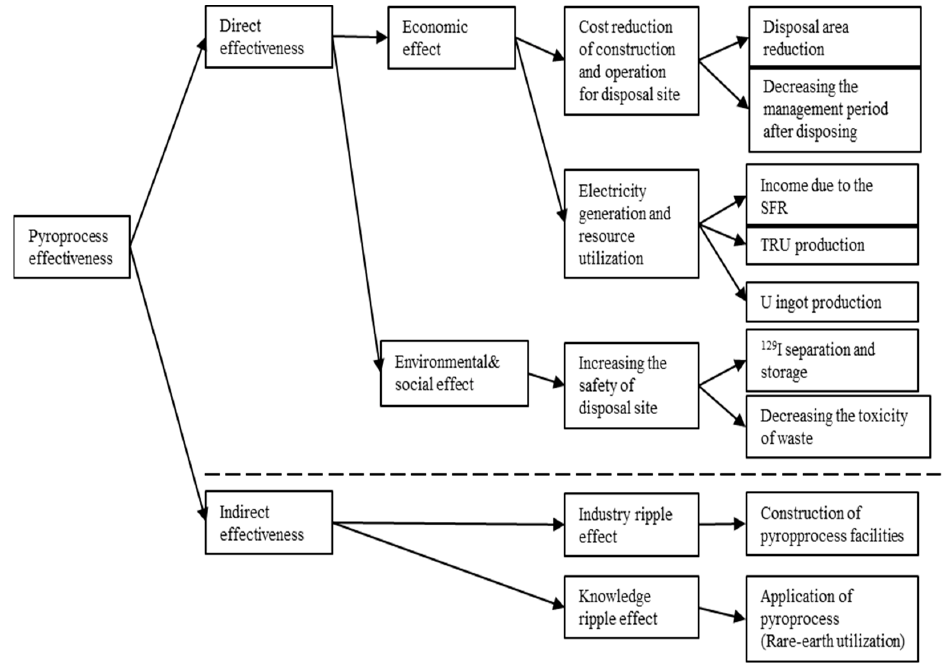
Figure 3. Pyroprocessing effectiveness structure. Table 1. Cost input data of direct disposal and Pyro-SFR fuel